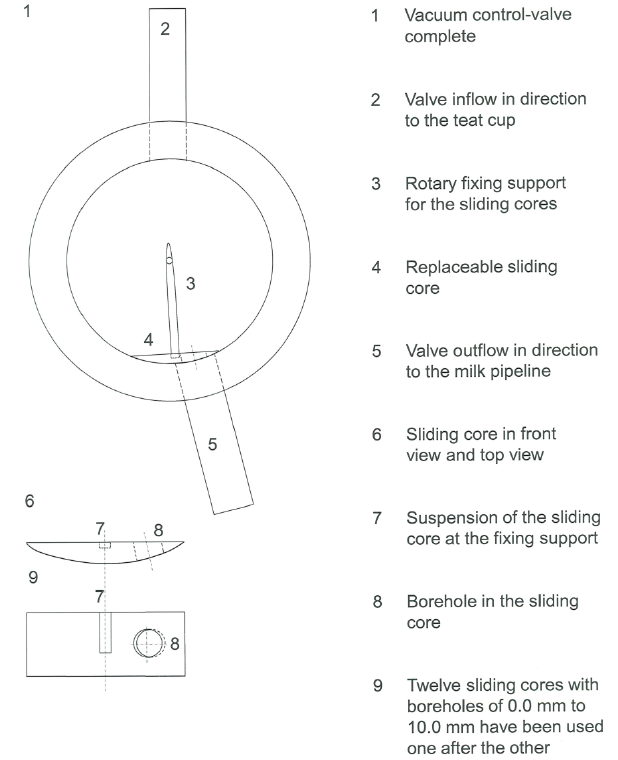
Figure 2. A drawing of the vacuum control valve (VCV), tosgether with an example for the twelve sliding cores, which were used for the tests